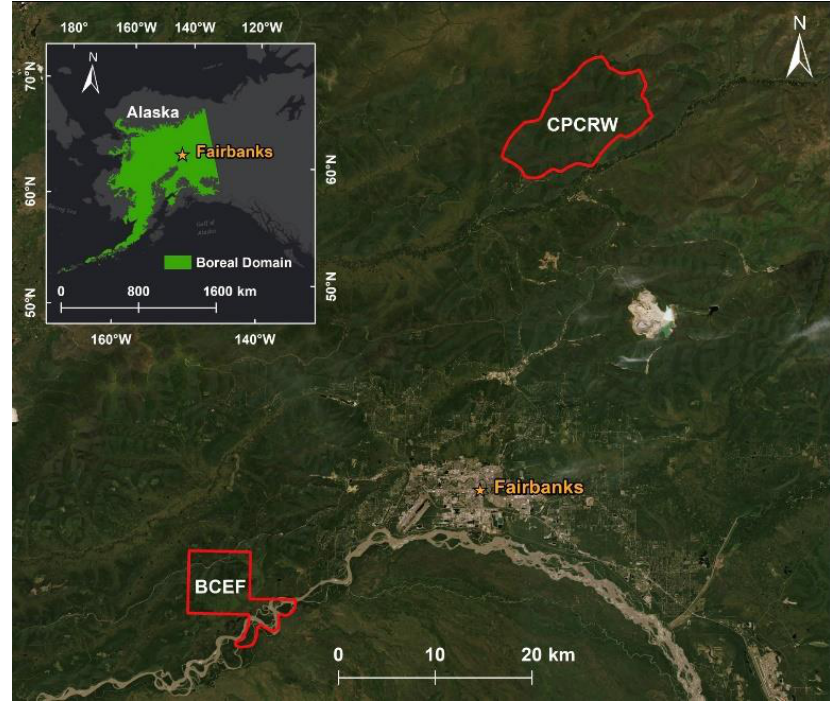
Figure 2. Map of the two study sites in relationship to the Alaskan Boreal Forest and Fairbanks. CPCRW is located 50km North of Fairbanks and BCEF is located 20km Southwest of Fairbanks.